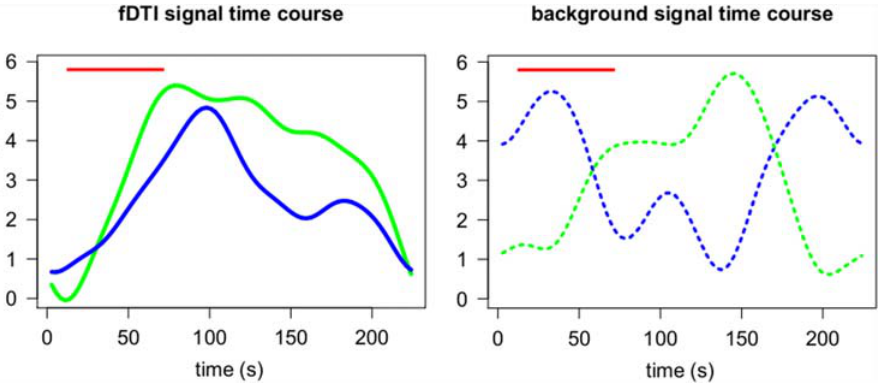
Figure 4. Time course experiment. The time courses of the diffusion weighted MRI signal for the visual and the tactile task measured perpendicular to the tract’s main direction using a single stimulus. An increase in glial cell volume is expected to lead to an increase of the measured signal. The tactile and the visual stimulus period (red horizontal line) started at t=12 s and ended at t=72 s. a) The results represent the averages of 15 measurements (3 subjects; 5 measurements per subject) smoothed using a Gaussian kernel with sigma=14 s. For the tactile stimulus (green) the maximum signal was found at t=78 s. For the visual stimulus (blue) the maximum signal was found at t=98 s. b) The averages of the signals of the background voxels that were used to correct for global signal variations (dashed blue line for the visual task and green dashed line for the tactile task). Note that these signals were independently scaled for visualization.